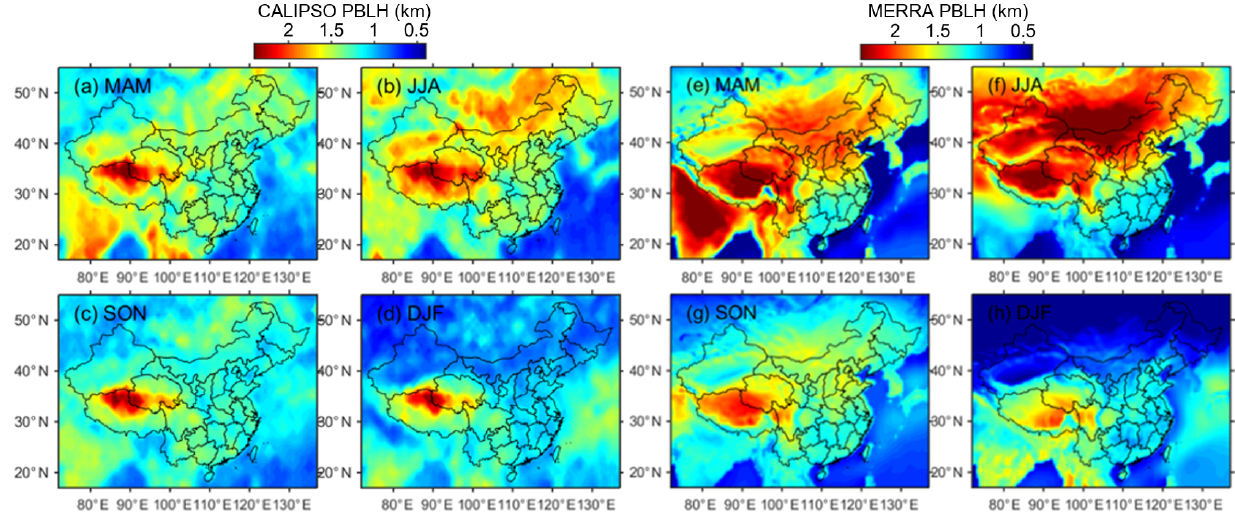
Figure 3. Spatial distributions of climatological mean PBLH derived from CALIPSO for (a) March–April–May (MAM), (b) June–July– August (JJA), (c) September–October–November (SON), and (d) December–January–February (DJF) during the period 2006–2017. Spatial distributions of climatological mean of early-afternoon PBLH obtained from MERRA for (e) MAM, (f) JJA, (g) SON, and (h) DJF during the period